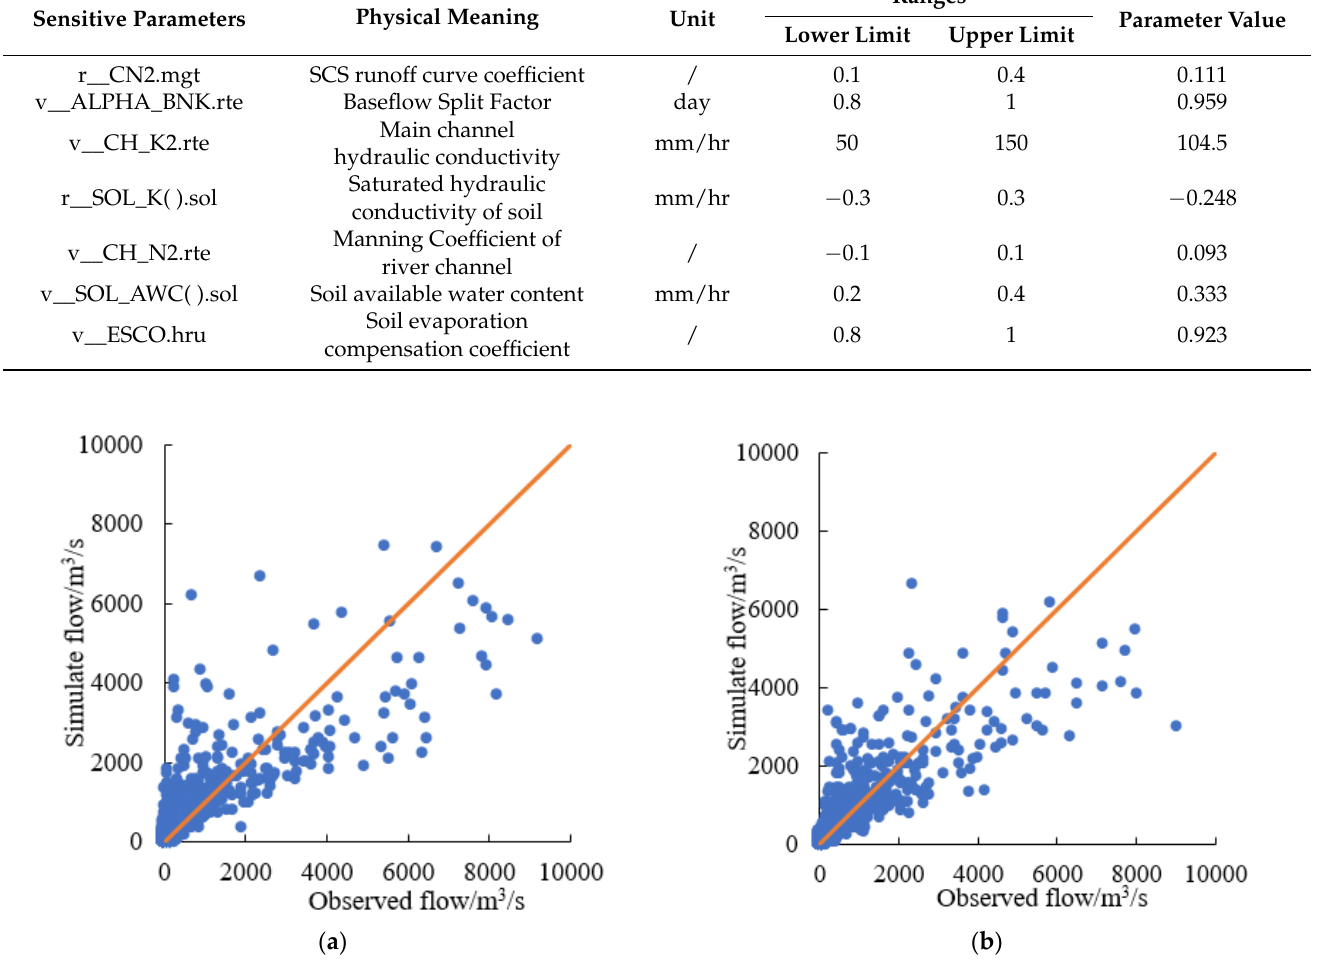
Figure 4. Simulated daily flow at Shiquan hydrologic station in the calibration and validation periods: ( a ) calibration period; ( b ) validation period. Table 3. Runoff sensitivity parameters of Shiquan hydrological station.